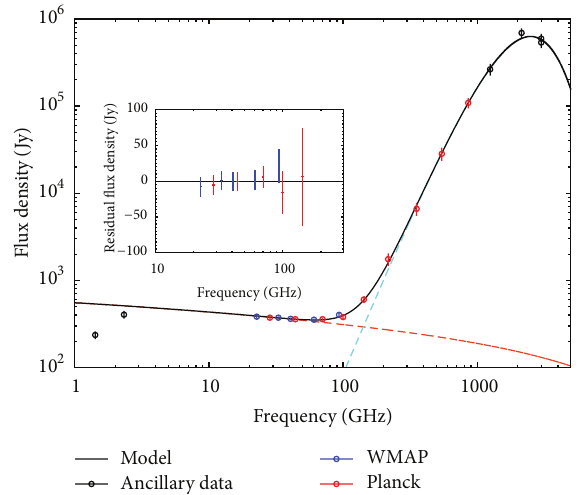
Figure 1: SED of the Orion Nebula (M42) HII region [4]. Free-free emission dominates at frequencies below 100GHz while thermal dust emission dominates above 100GHz. The free-free emission is optically thin above a few GHz. There is no evidence of significant